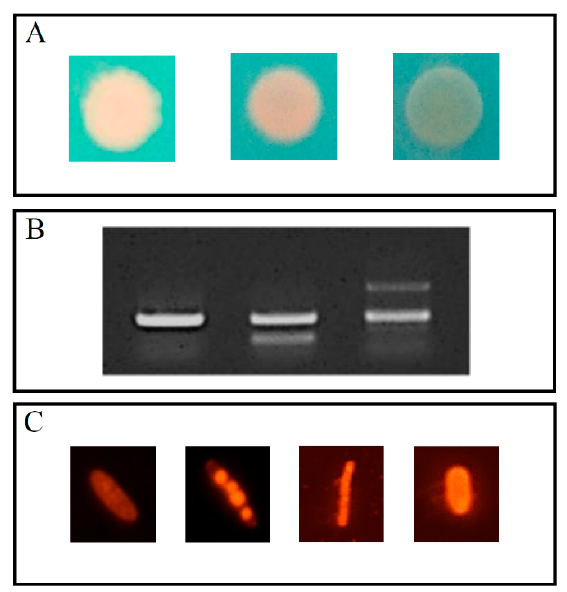
Figure 1. ( A ) Examples of drop growth fluorescence of bacterial strains in UV light on a R3A agar supplemented with Nile Red (from left to right): Janthinobacterium sp. 1167, Chryseobacterium sp. 966, Rhodanobacter sp. 2793. ( B ) Examples of PCR-amplification results (bands) of a phaC gene fragment using the G-D and G-1R primers by Romo et al. 2007 (left to right): Polaromonas sp. 1701 (550 bp band), Acidovorax sp. 1169 (300 bp and 550 bp band), Janthinobacterium sp. 1167 (550 bp and 1000 bp band), ( C ) Bacterial cell fluorescence in green light excitation (510–560 nm) after Nile Red staining (left to right): Janthinobacterium sp. 1167—“empty” cell, Janthinobacterium sp. 1167—granule-filled cell, Flavobacterium sp. 1052 cell scored as PHA negative (no granule outline), Psychromonas sp. 1212 cell scored as PHA negative (no granule